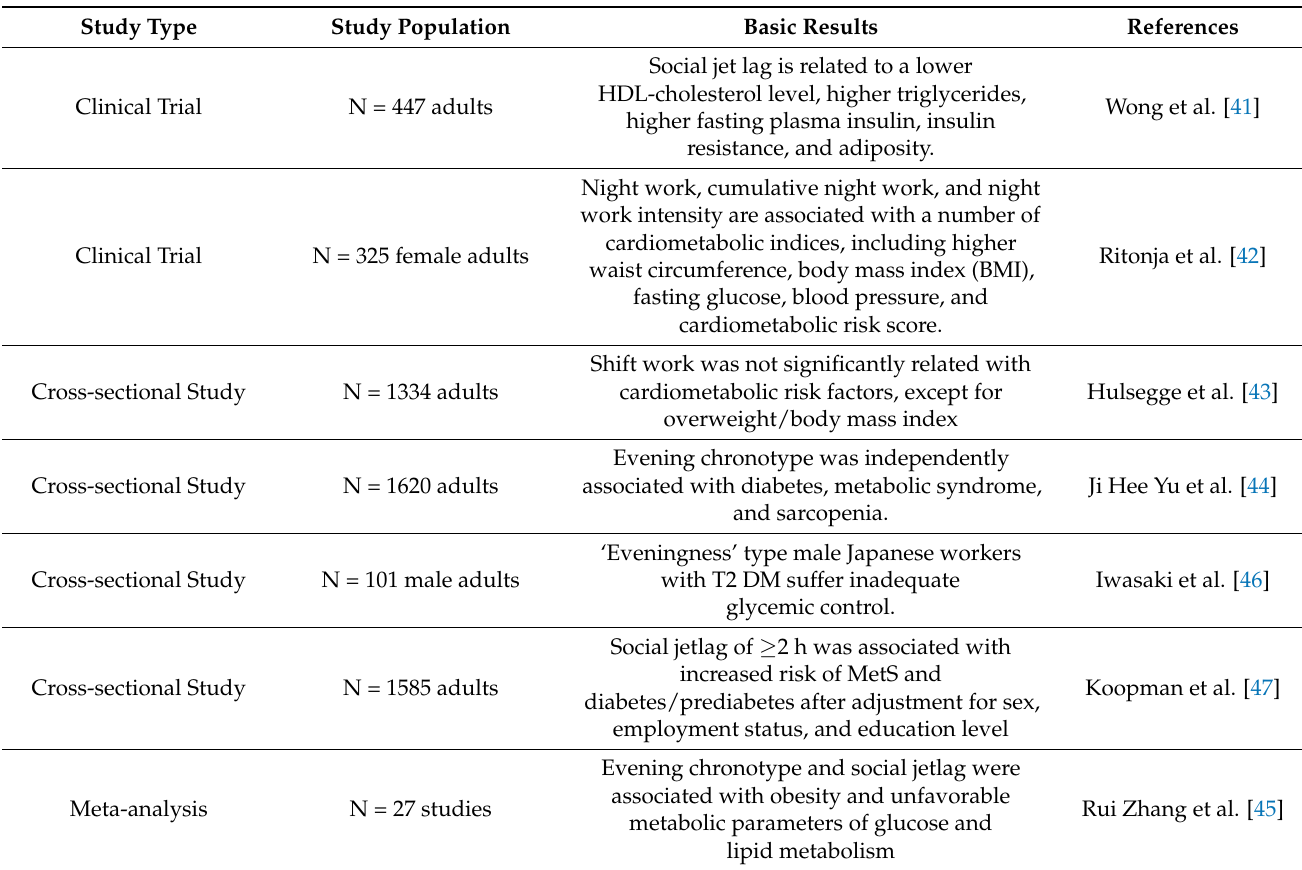
Table 2. Clinical studies analyzing the interrelationship between circadian rhythm, sleep disorder, and metabolic